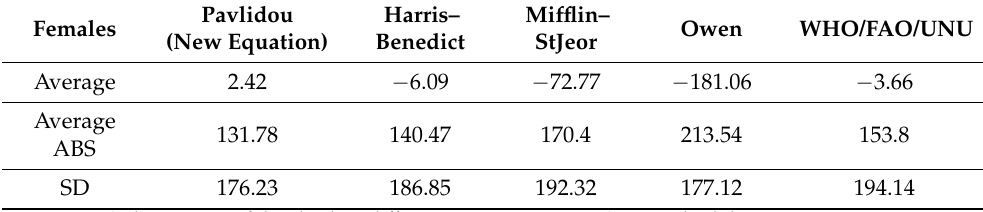
Table 6. Difference RMR P -RMR IC in